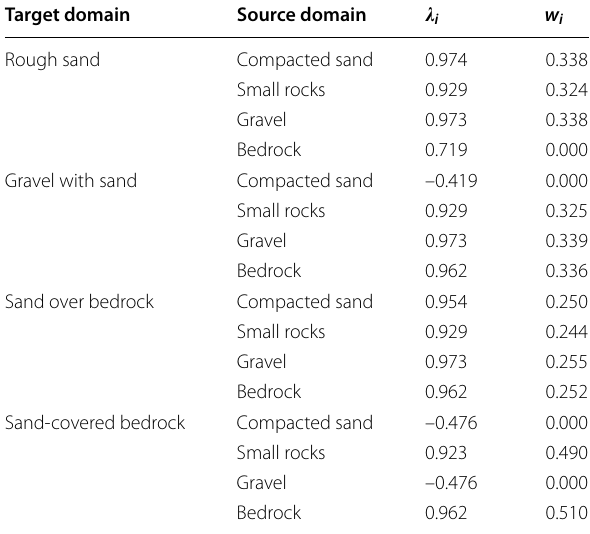
Table 2 RMSEs and LOGLIKs of reference GPR models for slip (Fig. 6) and power consumption (Fig. 7)